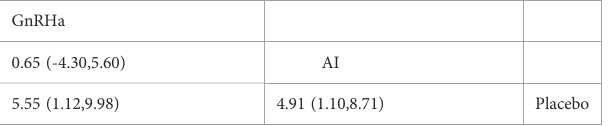
TABLE 3 Result of comparisons among